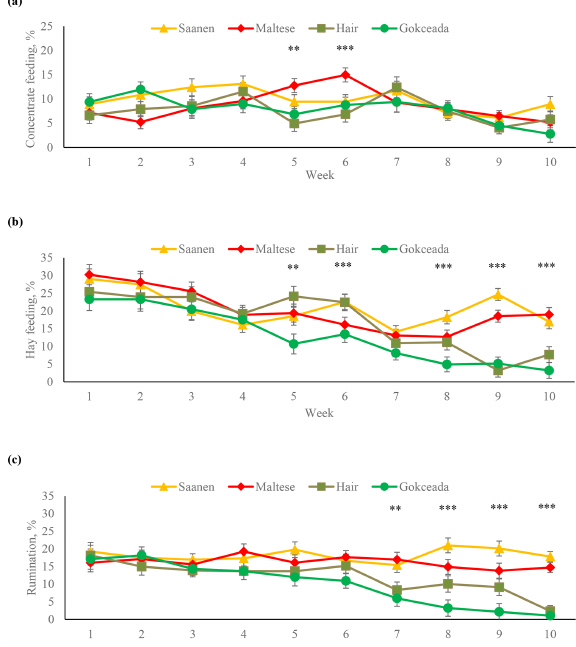
Figure 2. Percentages of (a) concentrate feeding, (b) hay feeding and (c) rumination behaviours at different fattening weeks accord- ing to breed. ∗∗ P < 0 . 01. ∗∗∗ P < 0 . 001.